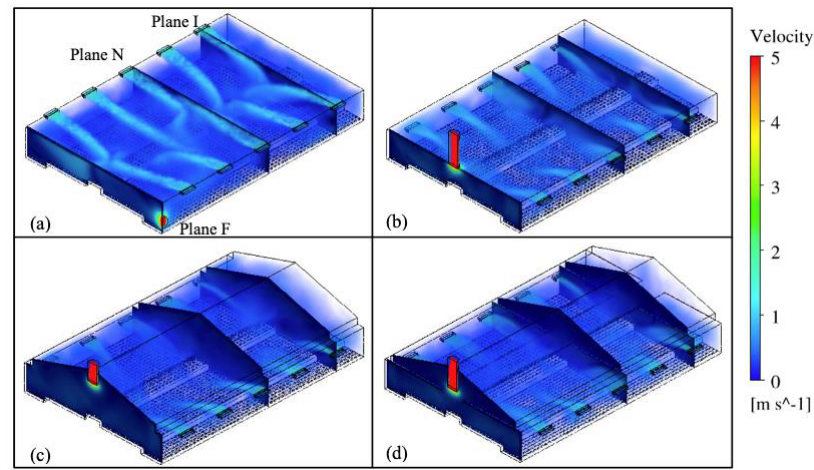
Figure 5. Isometric view of the study layer house showing the location of three reference planes as indicated in (1), and overall airflow patterns and air velocity magnitudes within four ventilation schemes: ( a ) TISE, ( b ) MICE, ( c ) MIRE, ( d ) MIAE.